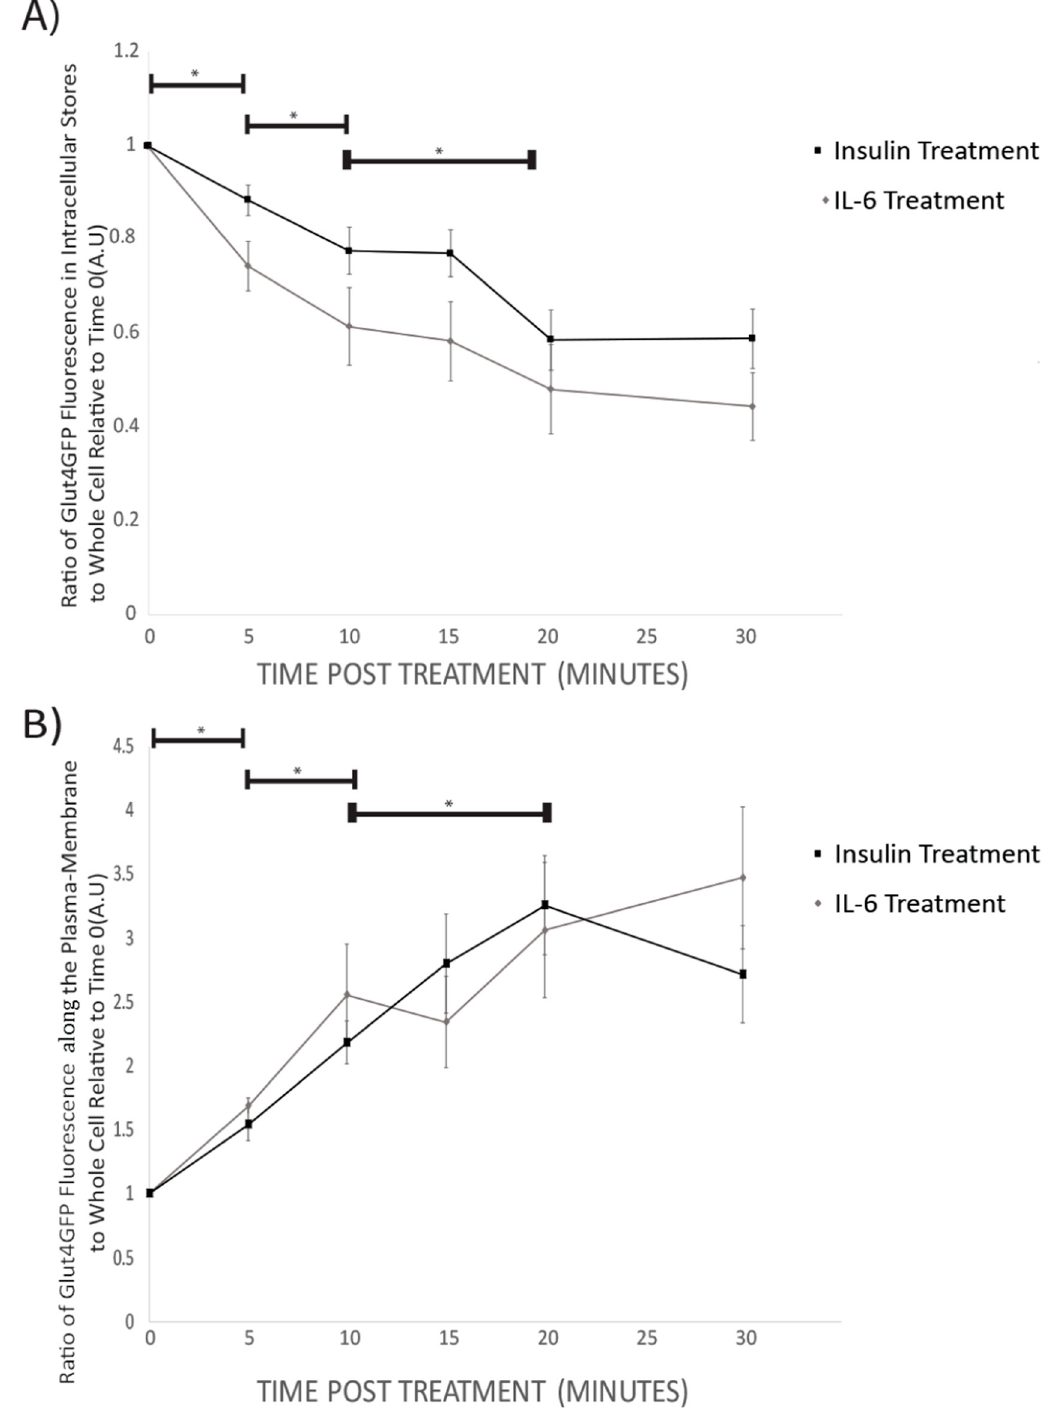
Figure 4. GLUT4-GFP Fluorescent Localization Quantification Following IL-6 and Insulin Treatment in Di ff erentiated SH-SY5Y Cells: SH-SY5Y cells were treated with 100nM of insulin, and 20ng / mL of IL-6 for 5, 10, 15, 20, and 30 min. ( A ) Ratio of intracellular store to whole-cell fluorescence of GLUT4-GFP Decreases with time both in IL-6 (n = 12) and insulin (n = 9) treated cells. ( B ) The ratio of GLUT4GFP along the plasma-membrane to whole cell fluorescence increases with time in both IL-6 (n = 12) and insulin (n = 9) treated cells. Data are presented as means ± SE. A.U., arbitrary units. * p < 0.05 as determined using a Mann-Whitney U test between each time point.